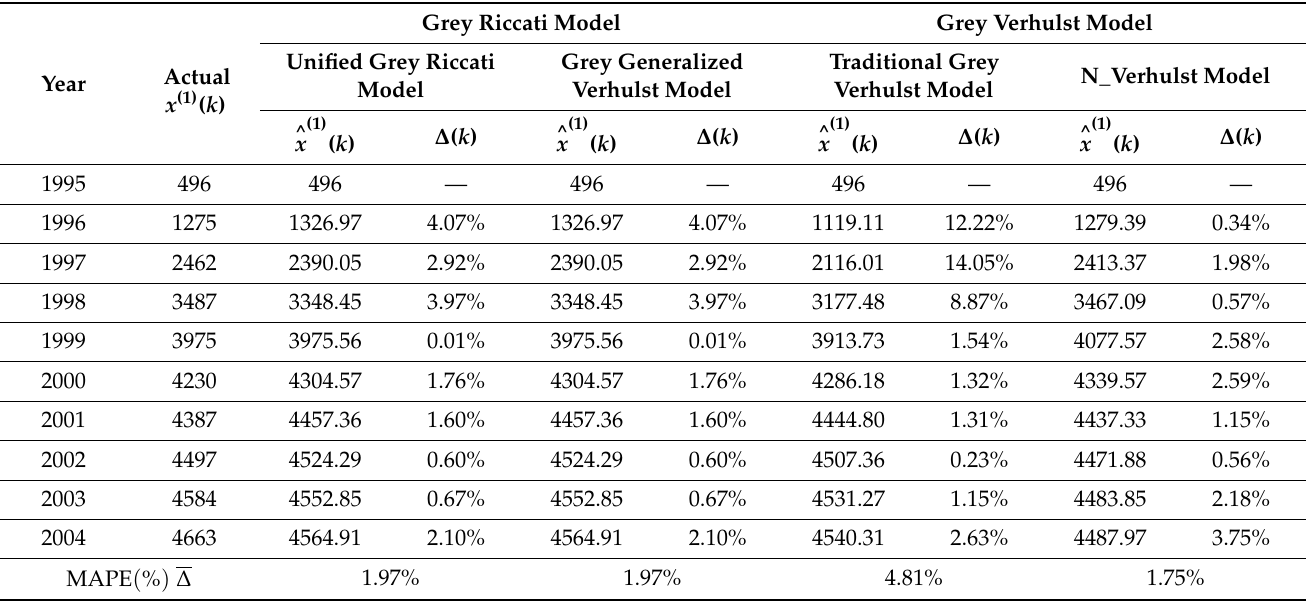
Table 1. Actual and simulative results of accumulated expenditures on the research of a certain type of torpedo (Unit: million